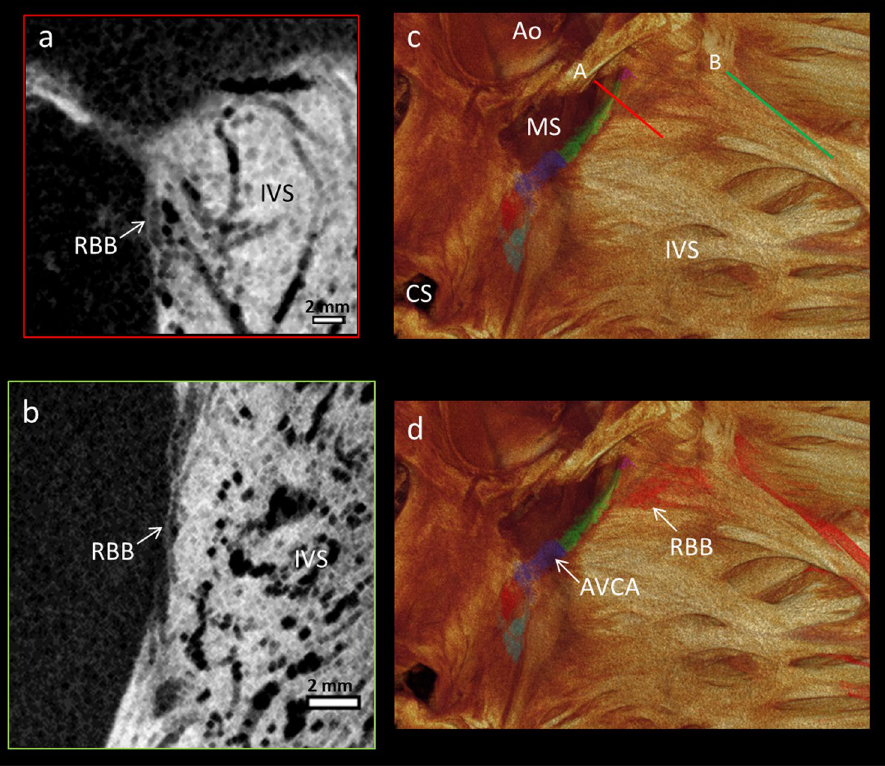
Figure 4. Segmentation of the right bundle branch. The high resolution (73 × 73 × 73 µ m 3 ) micro-CT data from the whole human heart, showing the 3D extent and position of the segmented right bundle branch (red in panel d) on the lateral aspect of the interventricular septum ( c , d ), as viewed from within the right ventricular cavity. Illustrative long-axis micro-CT sections showing the proximal ( a ) and distal ( b ) aspects of the right bundle branch. From the view in ( d ) a part of the so-called dead-end tract at the anterior/rostral extent of the atrioventricular conduction axis can be identified (purple). The position of the cross-sections ( a , b ) are shown in the 3D volume rendering in ( c ). Ao- Aortic root, AVCA- atrioventricular conduction axis, CS- coronary sinus, IVS- interventricular septum, MS- membranous septum, RBB- right bundle